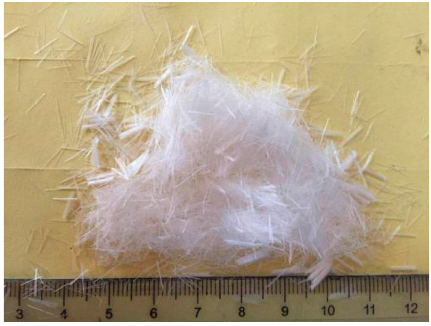
Figure 2: Polypropylene